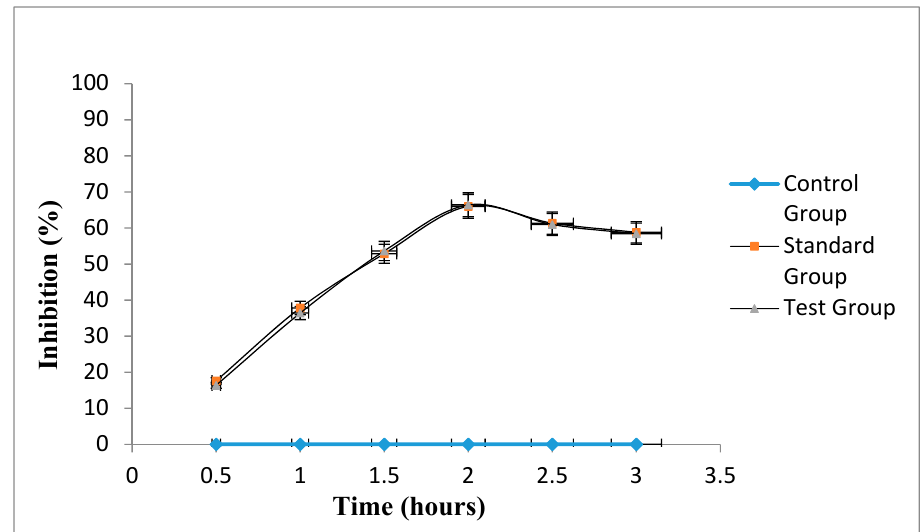
Figure 4. Percent edema inhibition of the standard group and test group.